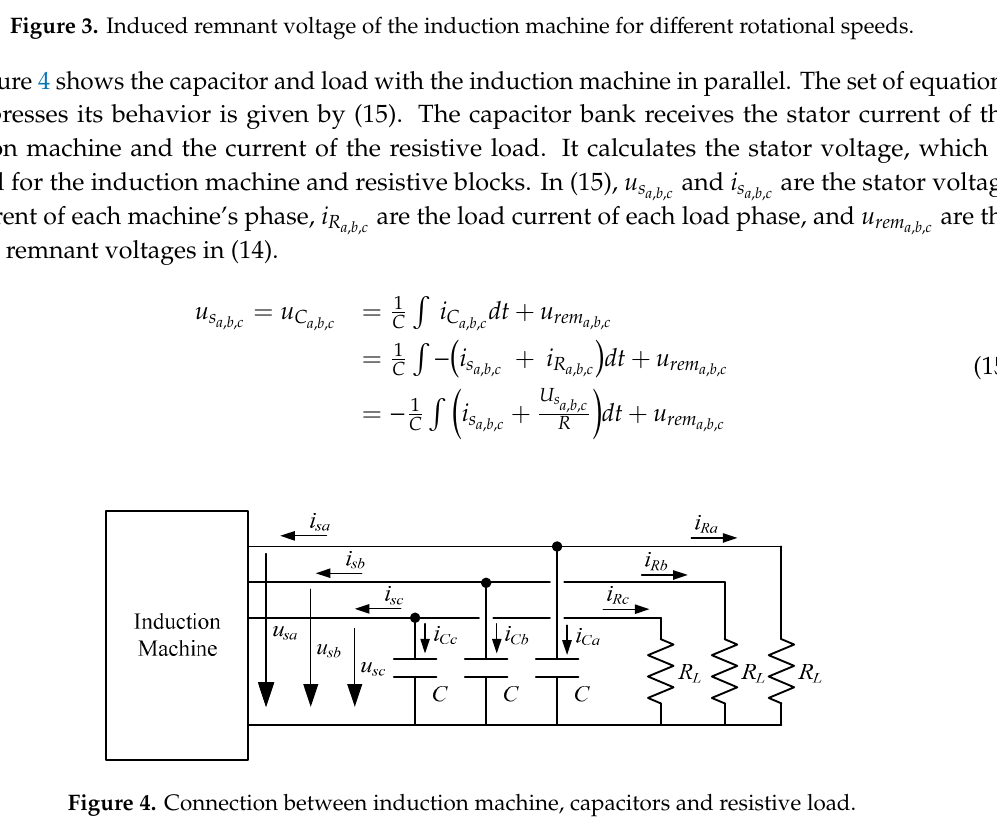
Figure 4. Connection between induction machine, capacitors and resistive load.